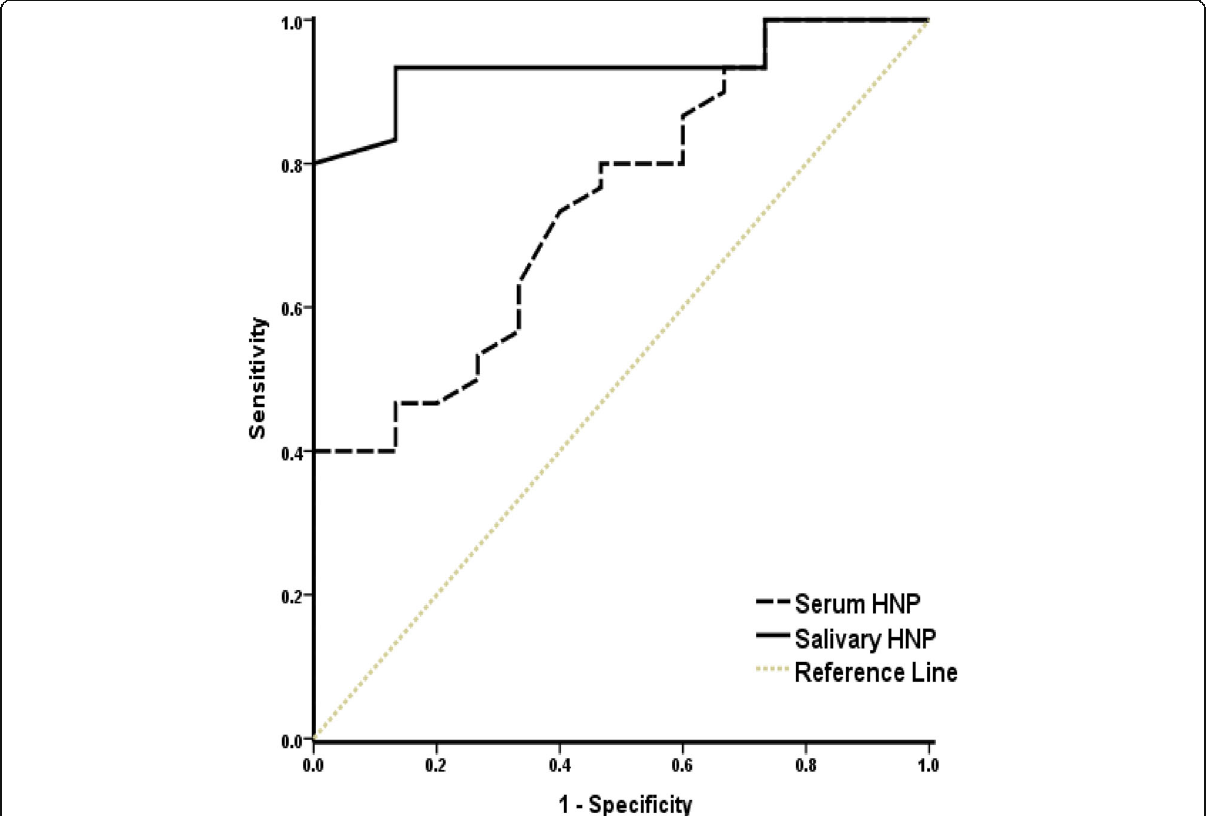
Fig. 1 Receiver operating Characterestic (ROC) analysis on utility of serum and salivary α defensins 1-3 for discrimination between cases and controls. Serum α -defensins 1-3 showed a fair area under the curve (AUC) = 0.743, 95% confidence interval (CI) for the AUC (0.657 – 0.830) with sensitivity of 40% and specificity 100% at cutoff value of 17.3 μ g/ml, while salivary α -defensins 1-3 showed excellent AUC = 0.936, 95% CI for the AUC (0.887 – 0.984) with sensitivity of 93.3% and specificity of 86.7% at cutoff value of 9.8 μ